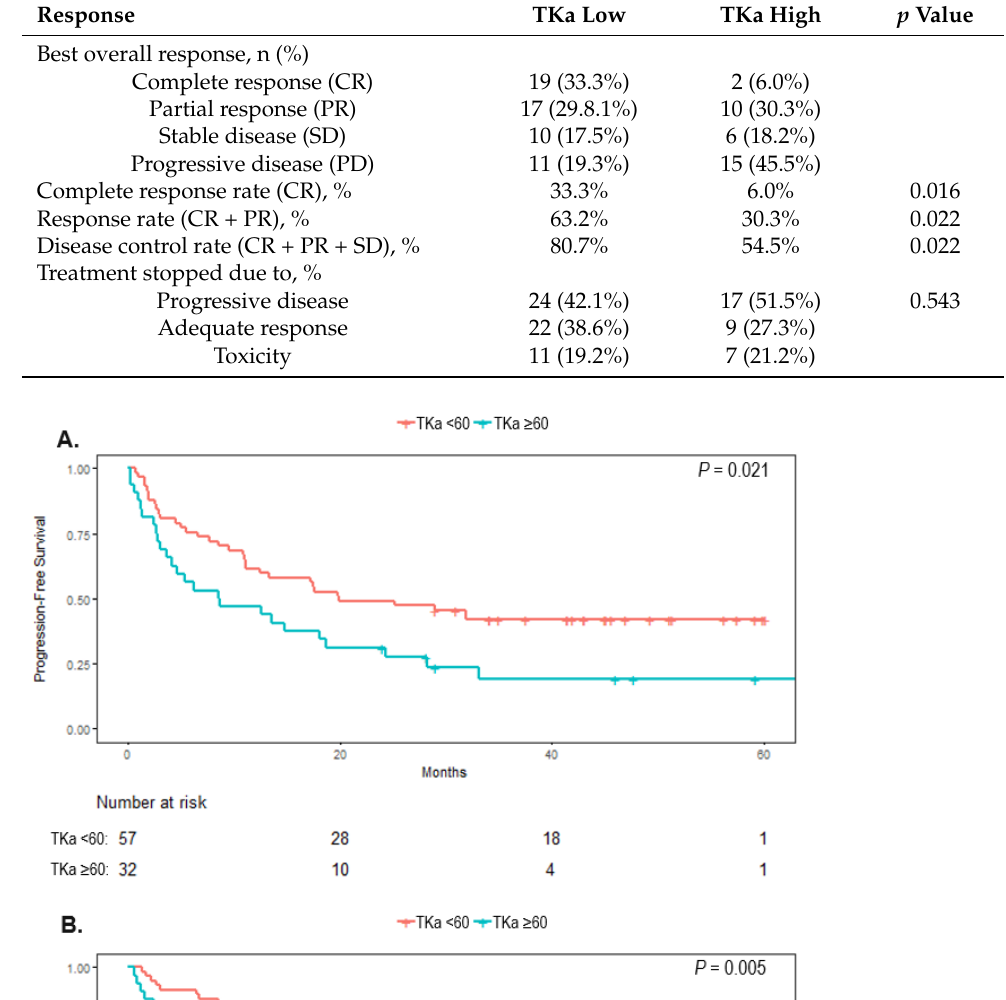
Table 3. Response evaluations in melanoma patients with low (<60 Du/L) or high thymidine kinase 1 (TK) activity (Du/L) in plasma before starting immune checkpoint inhibitor treatment.